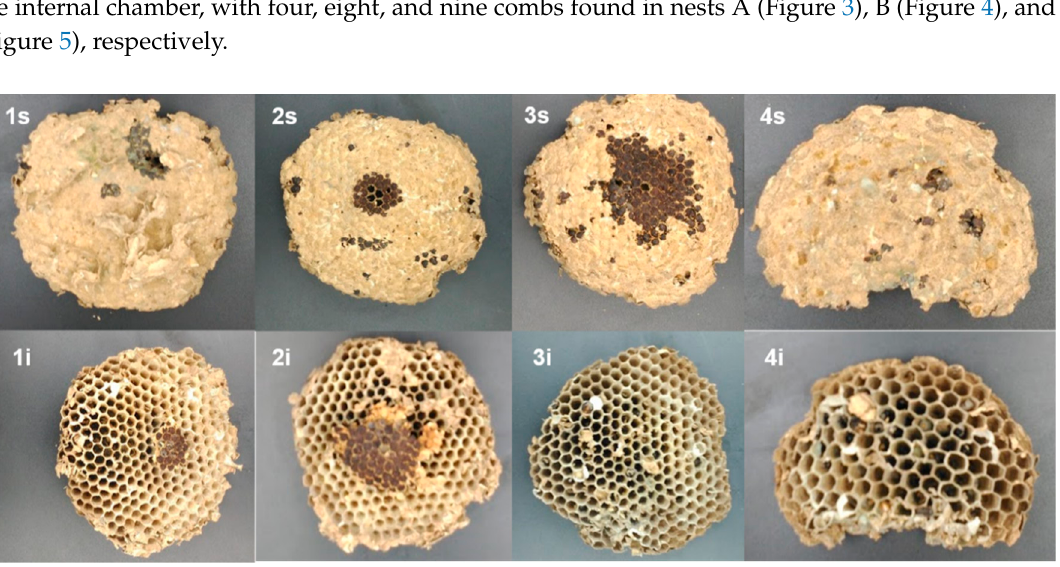
Figure 3. Combs taken from V. velutina nest A. The figures show both superior (s) and inferior (i) views of the combs labeled from top to bottom (1–4) in the same order that they were found within the nest.